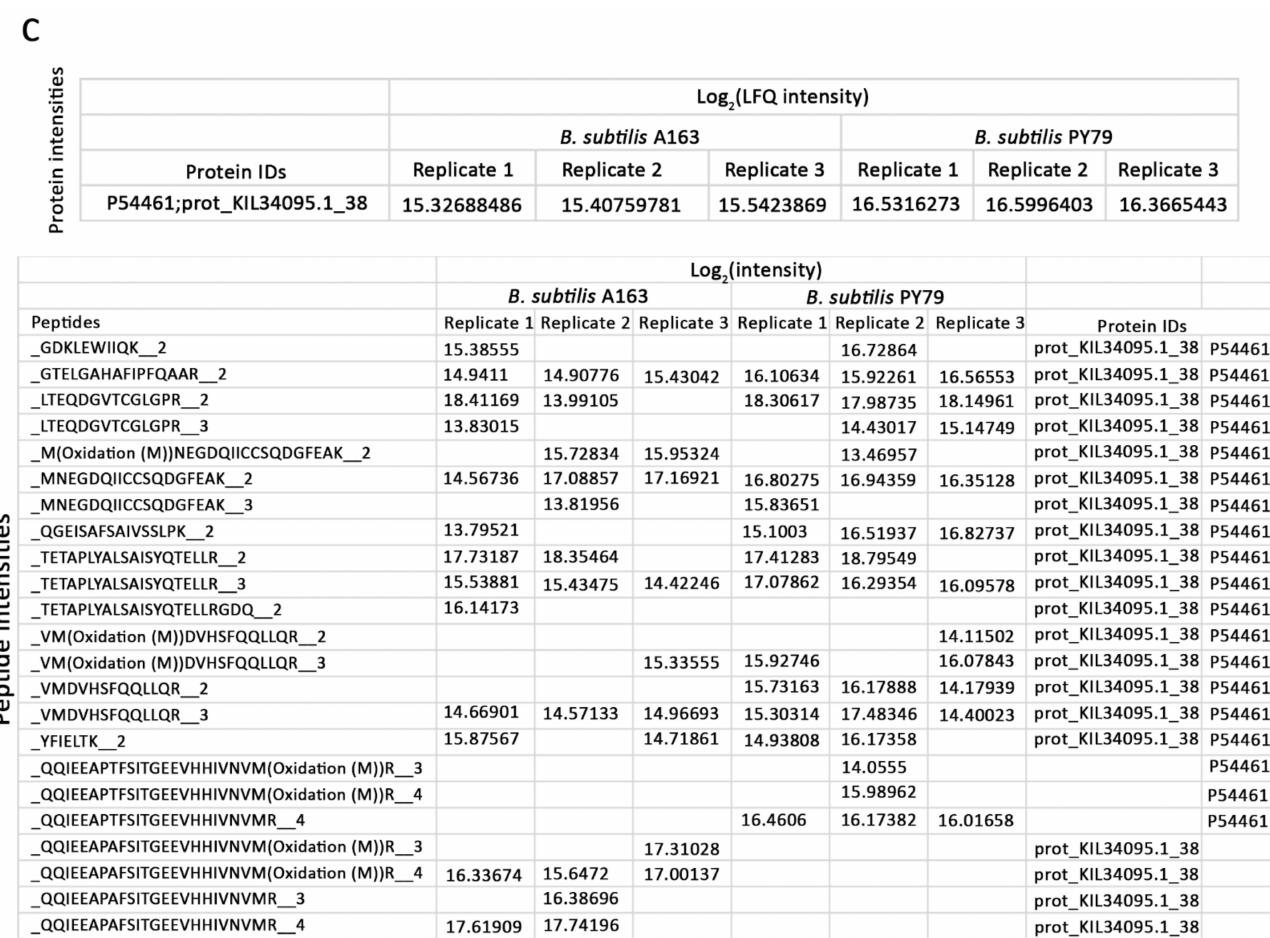
Figure 3. Quantitative comparison of RsmE peptide levels in growing B. subtilis PY79 and A163 cells. prot_KIL34095.1_38, identifier of the homologous protein of RsmE in B. subtilis A163; LFQ, Relative label-free quantification [39]. ( A ) Alignment of amino acids of RsmE between two strains. ( B ) Protein intensities of RsmE and their identified peptides in the default output. ( C ) Protein intensities of RsmE and their peptide components in the new